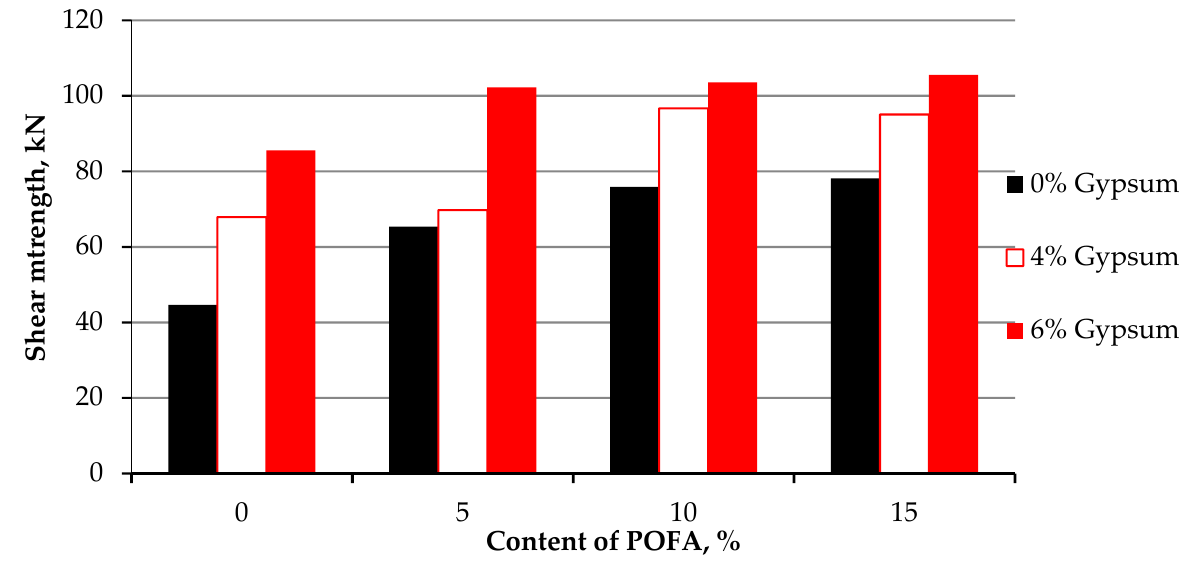
Figure 11. Stress–strain curve of kaolin and stabilized kaolin with gypsum and POFA tested after 7 days of curing. Table 5. Summary of variance and standard deviation of the specimen of shear strength after 7 curing